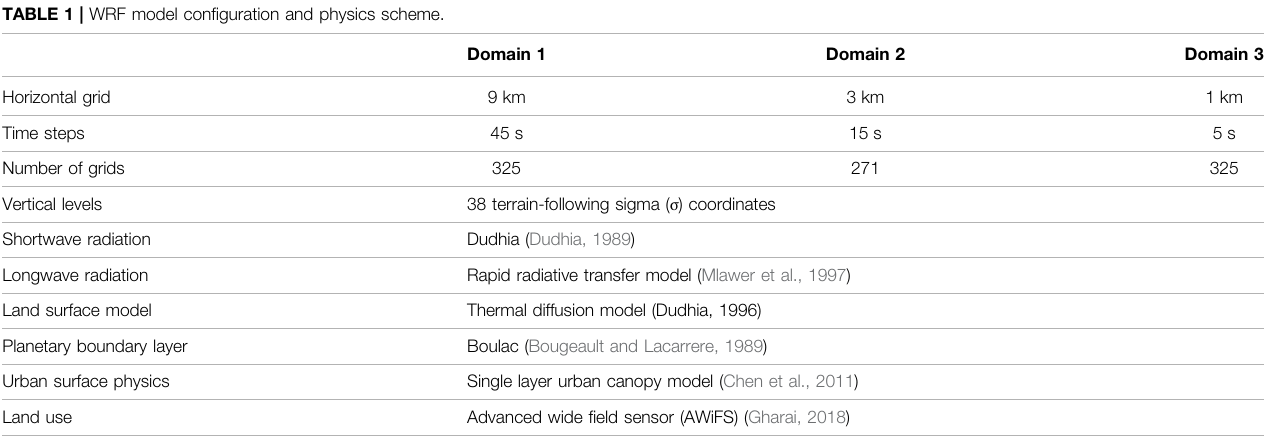
TABLE 1 | WRF model con fi guration and physics